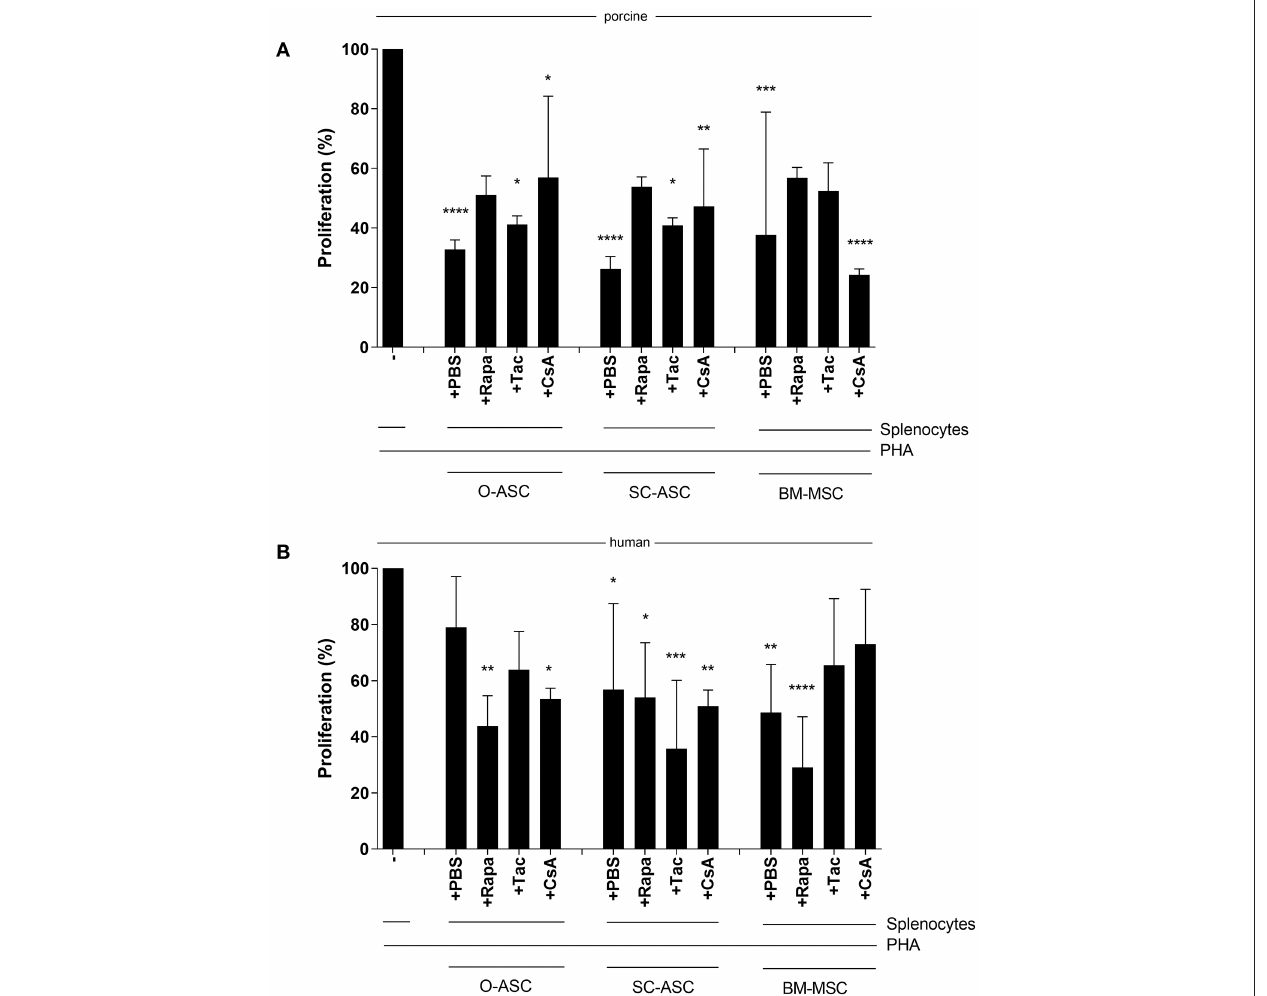
FIGURE 7 | Susceptibility of MSC immunosuppressive function to immunosuppressive agents. Mixed lymphocyte reaction assays (MLR) were performed to assess the immunomodulatory potential of the three cell lines (O-ASC, SC-ASC, and BM-MSC) head-to-head of both porcine (A) and human (B) origin after incubation with immunosuppressive agents at therapeutic dosage (Tacrolimus 10ng/mL, Rapamycin 10ng/mL, Cyclosporin A 250ng/mL) for 36h. Yorkshire splenocytes were stimulated with PHA and co-cultured with the different cell lines at a 4:1 ratio. Expressed as percentage proliferation in relation to positive control. Error bars = SD. Two-way ANOVA with Tukey post-test. * p < 0.05, ** p < 0.01, *** p < 0.001, **** p < 0.0001 vs. control (splenocytes +